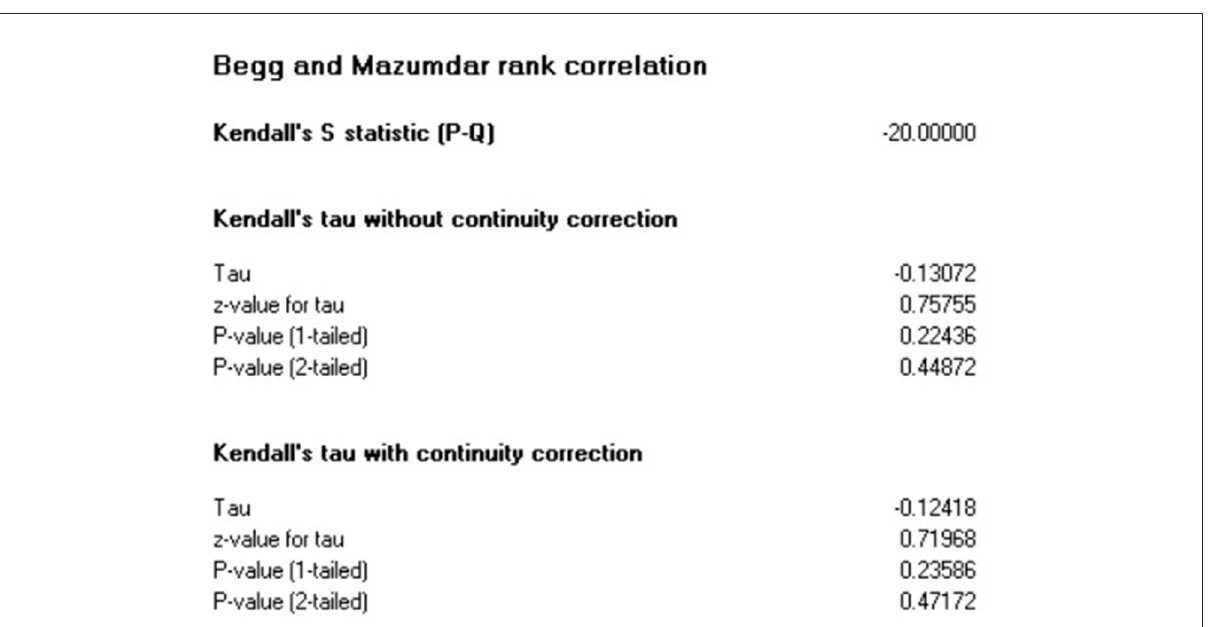
FIGURE8 Egger’s test and Begg and Mazumdar rank correlation publication bias test among lead battery factory workers studies in LMIC 2022 ( n =